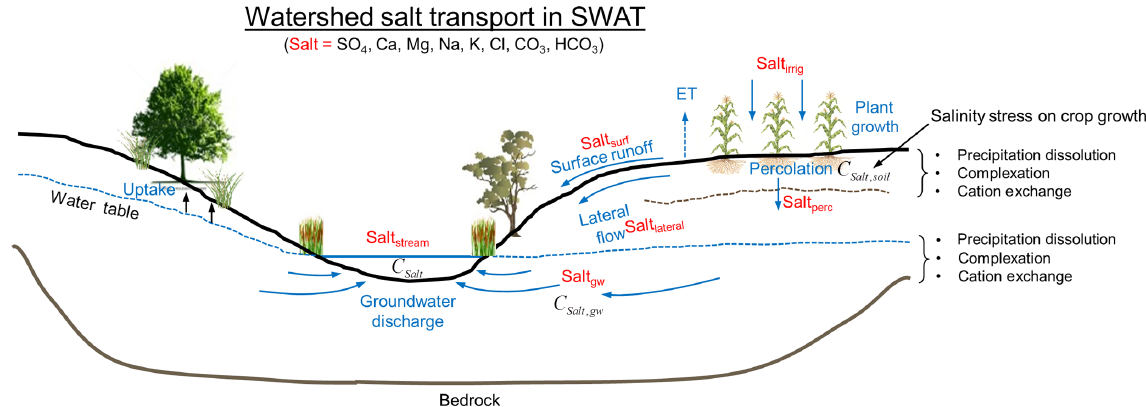
Figure 1. Schematic showing a cross section of an irrigated stream–aquifer system and the major transport pathways of salt, which consists of the eight major ions of SO 4 , Ca, Mg, Na, K, Cl, CO 3 , and HCO 3 . The concentration of each ion is also governed by equilibrium chemistry reactions such as precipitation–dissolution, complexation, and cation exchange within the soil profile and within the